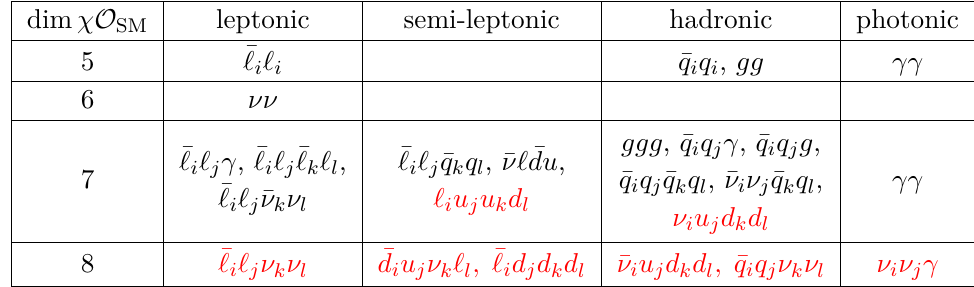
Table 1 . Summary of final states generated in SMEFT for spin-0 LLP decay for different decay operator dimensions. Final states highlighted in red violate global SM symmetries B or B − L